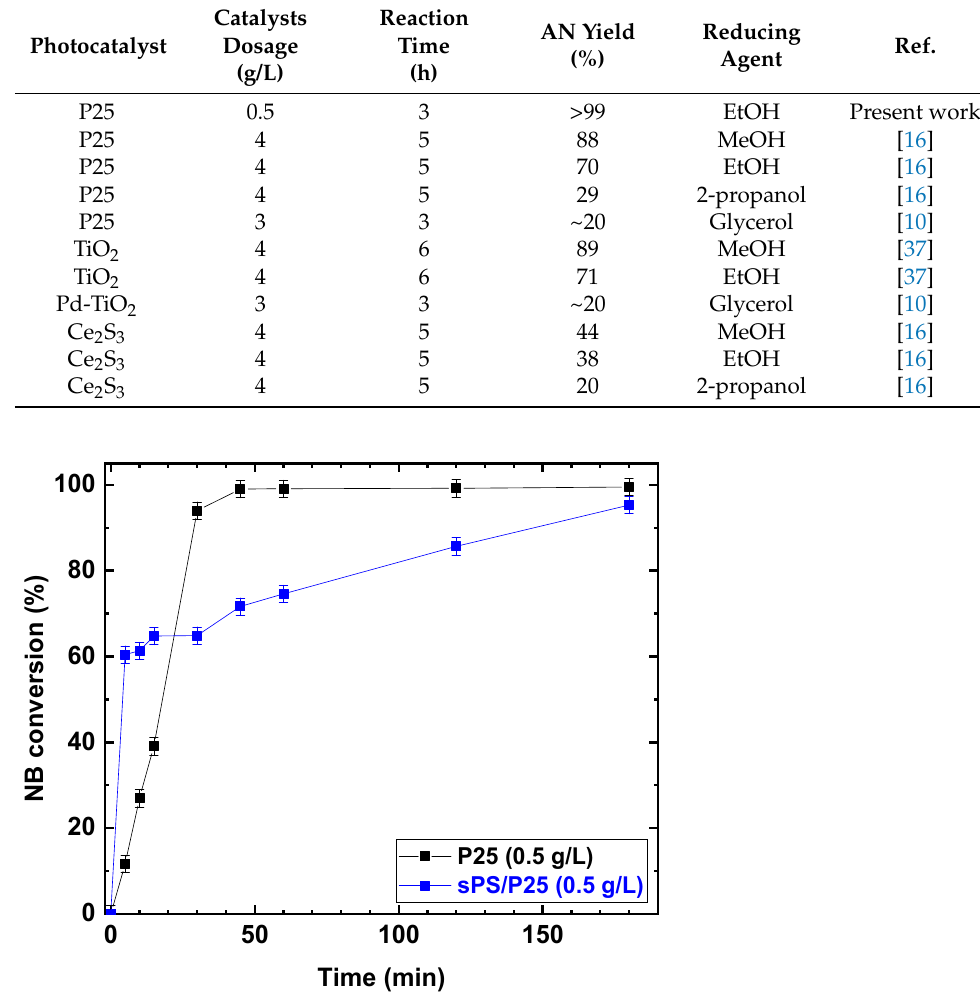
Figure 9. Comparison of the photocatalytic reduction of NB to AN with P25 and sPS/P25 aerogel. Reaction conditions: NB 1 mmol/L; water 100 mL; temperature 25 ◦ C. Error bar ±